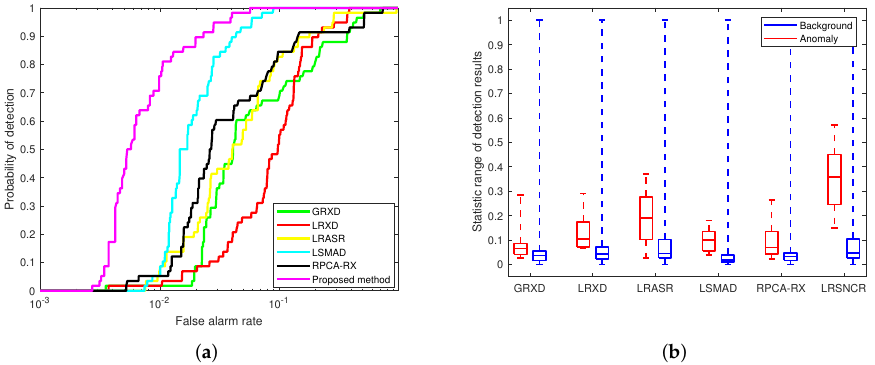
Figure 23. ROC curves and separability map acquire through the Sandiego dataset. ( a ) ROC curves. ( b )